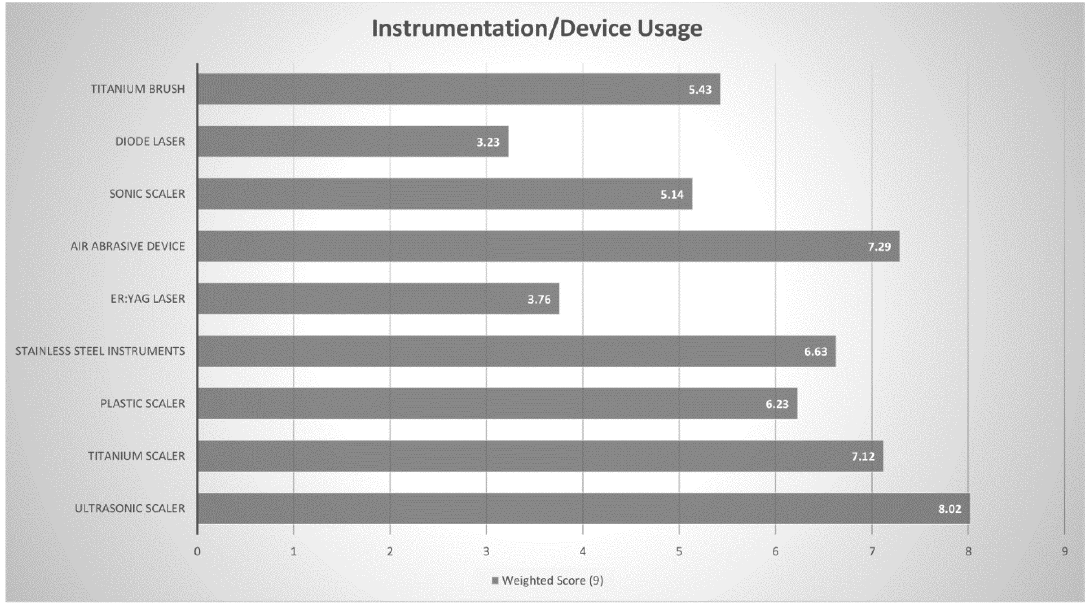
Figure 5. Instrumentation/Device Weighted Score (Out of 9).